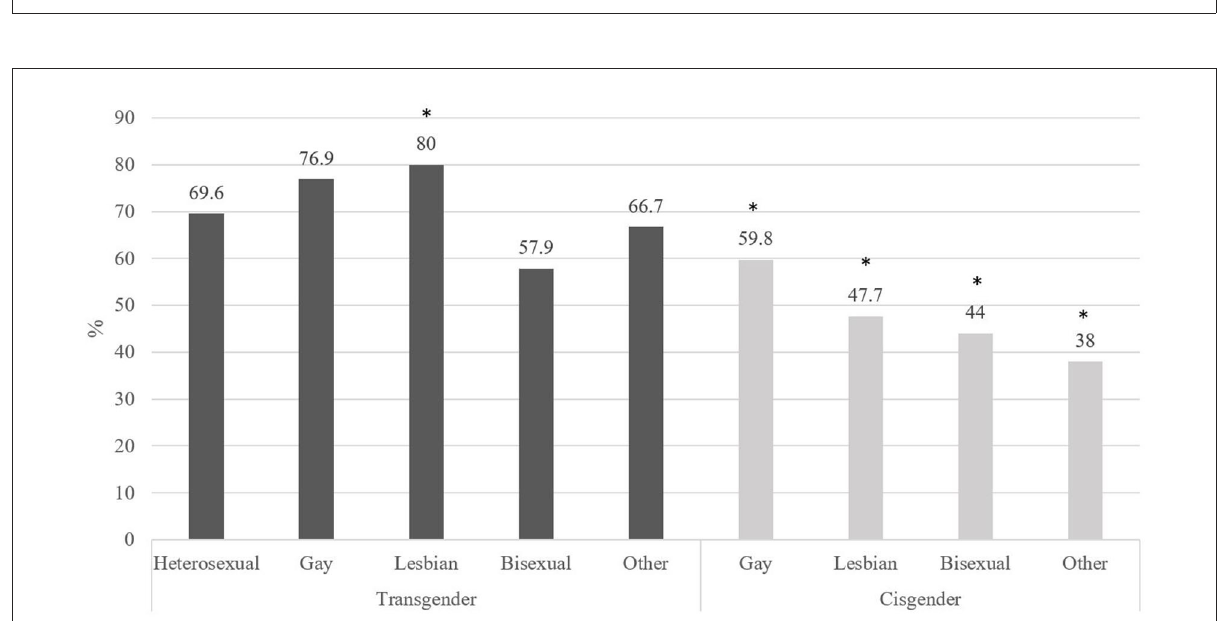
FIGURE2 Percentage of harassment by sexual